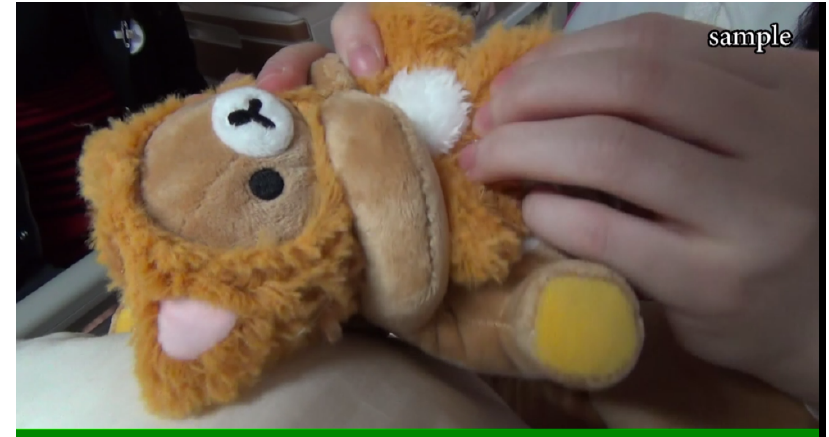
Fig. 5. “Give up? No!” After